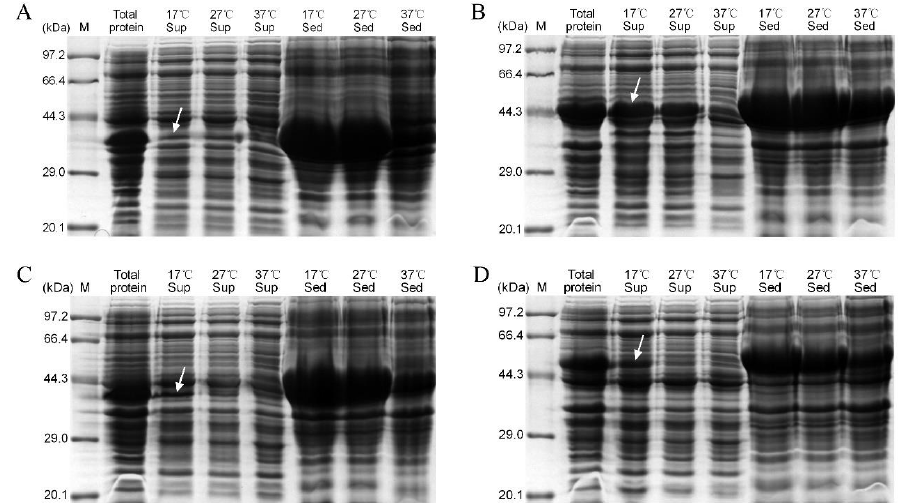
Figure 5. SDS-PAGE analysis of recombinant PlTLP proteins. ( A ) recombinant PlTLP1 . ( B ) recombinant PlTLP2 . ( C ) recombinant PlTLP3 . ( D ) recombinant PlTLP4 . M: protein marker. Sup: supernatant. Sed: sediment. Arrows indicate the soluble recombinant PlTLPs .